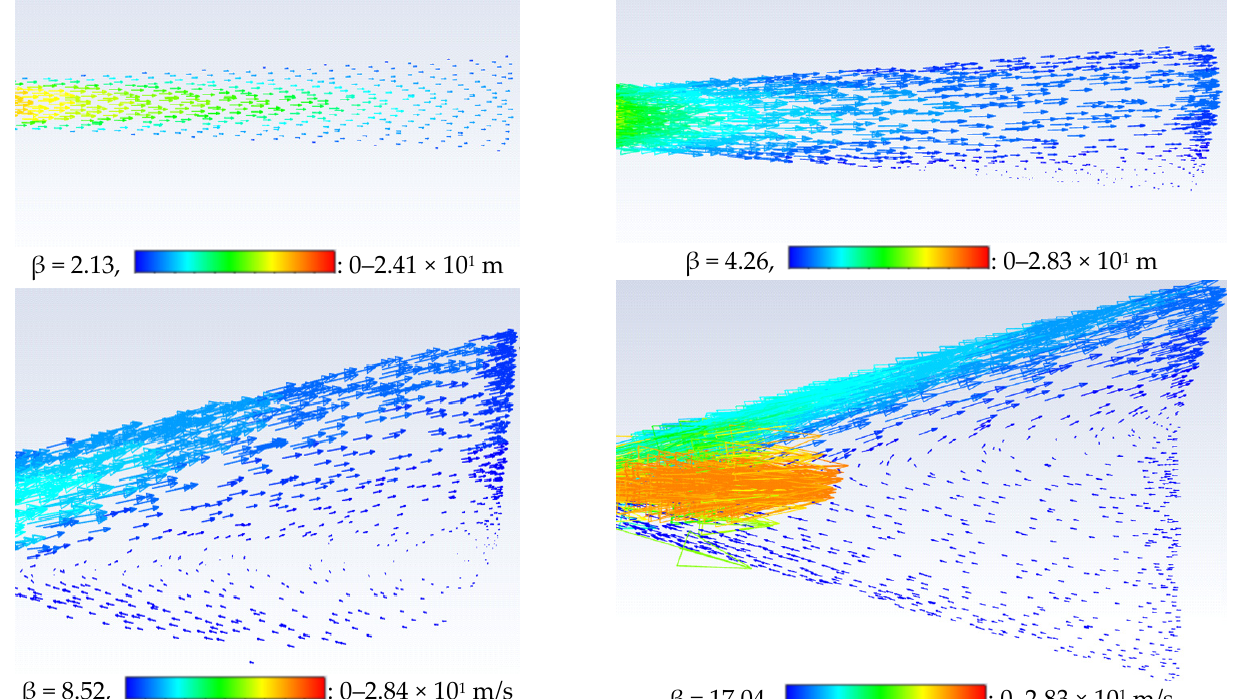
Figure 17. The velocity vectors for different diverging angles. (Water flow rate = 8.21 L/min, air flow rate = 0.1 L/min).